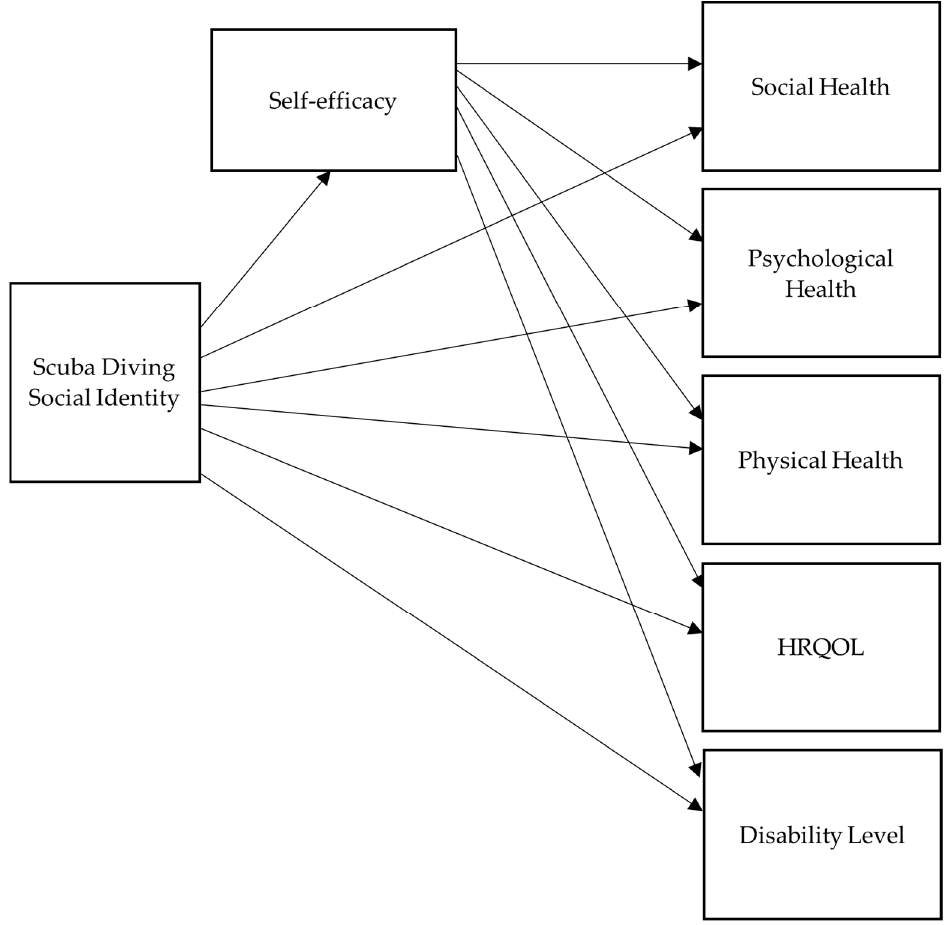
Figure 2. Hypothesized model or path diagram.